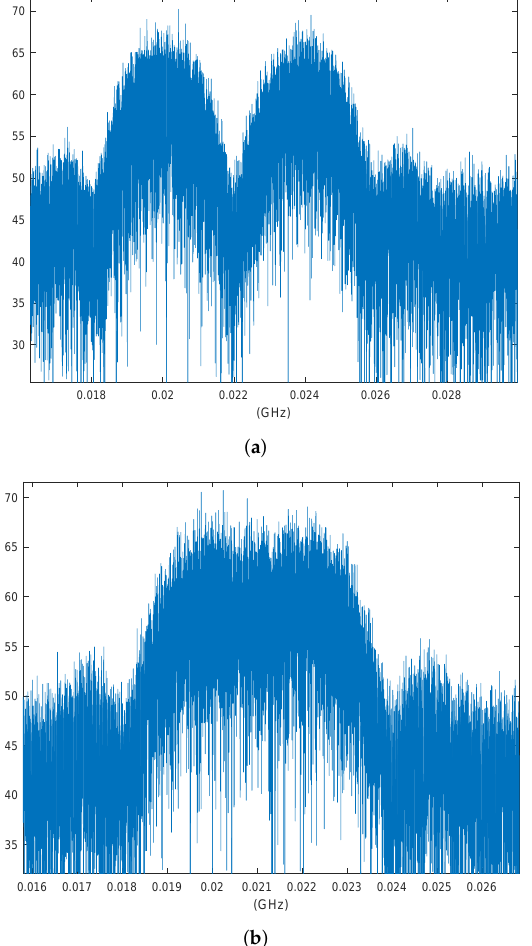
Figure 9. Spectra of QPSK authorized signal and adjacent subcarrier of NC-OFDM: ( a ) Spectrum with ∆ F = 0; ( b ) Spectrum with ∆ F =